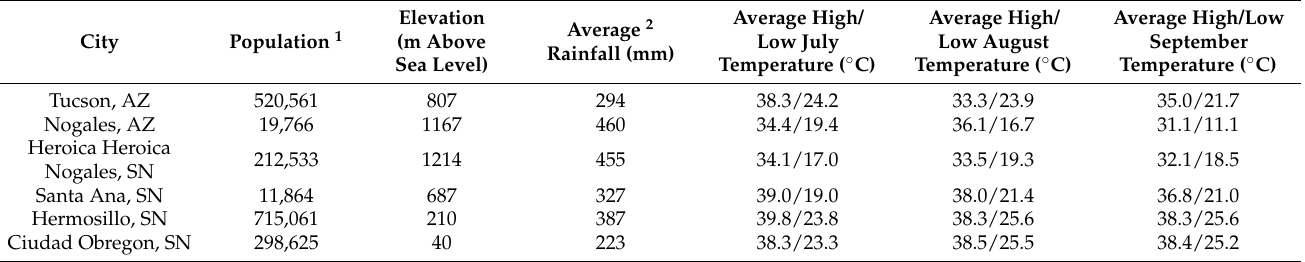
Table 1. Climate averages among study site